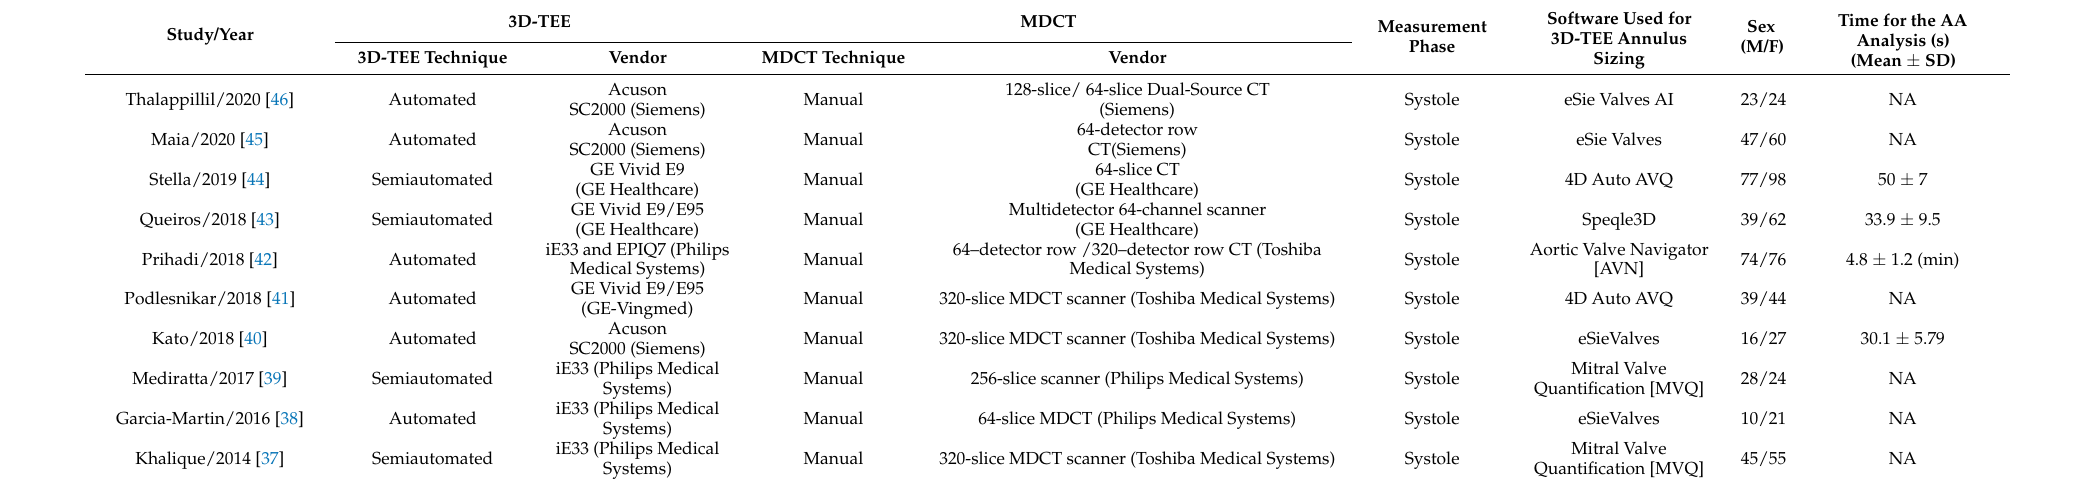
Table 3. Imaging characteristics of included